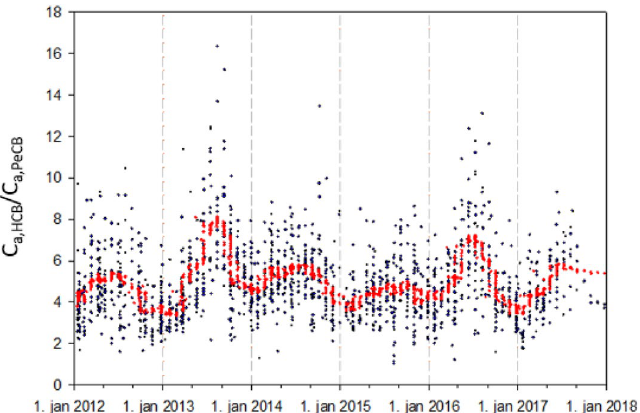
Figure 1. Temporal variations in HCB/PeCB ratios for passive air concentrations measured at European background sampling locations. Note: in red is the 7-day moving average of all data and is given only for visual